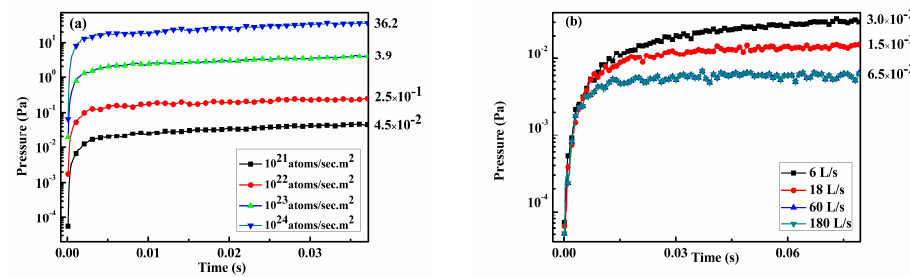
Figure 4. Variation in the pressure as a function of ( a ) gas flux and ( b ) pumping speed.